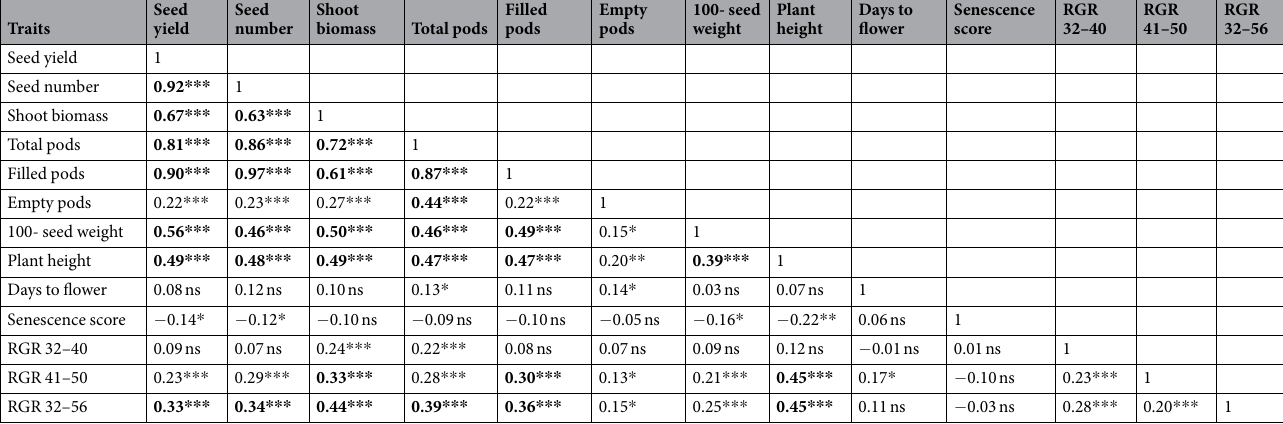
Table 3. Relationship between traits, salt relative to control (salt/control), determined by correlation analysis. Highlighted, are moderate to high correlation coefficients. RGR-relative growth rate. Level of significance